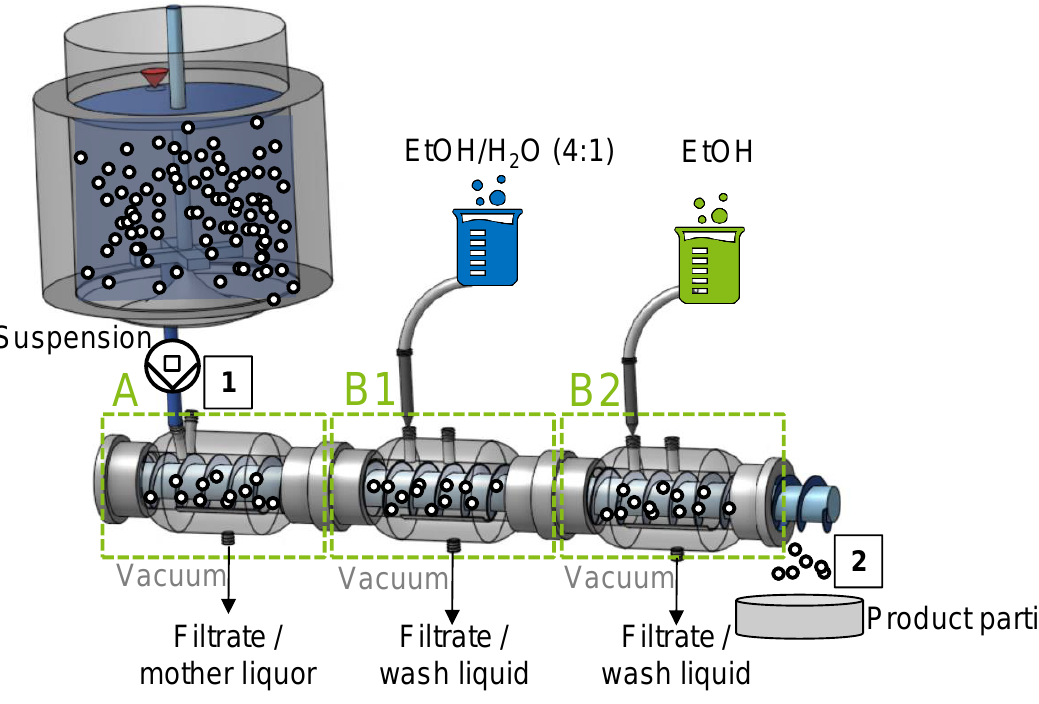
Figure 1. Experimental setup of the experiments with varying particle shapes. The CVSF consists of the module A (filtration), module B1 (1st washing), and module B2 (2nd